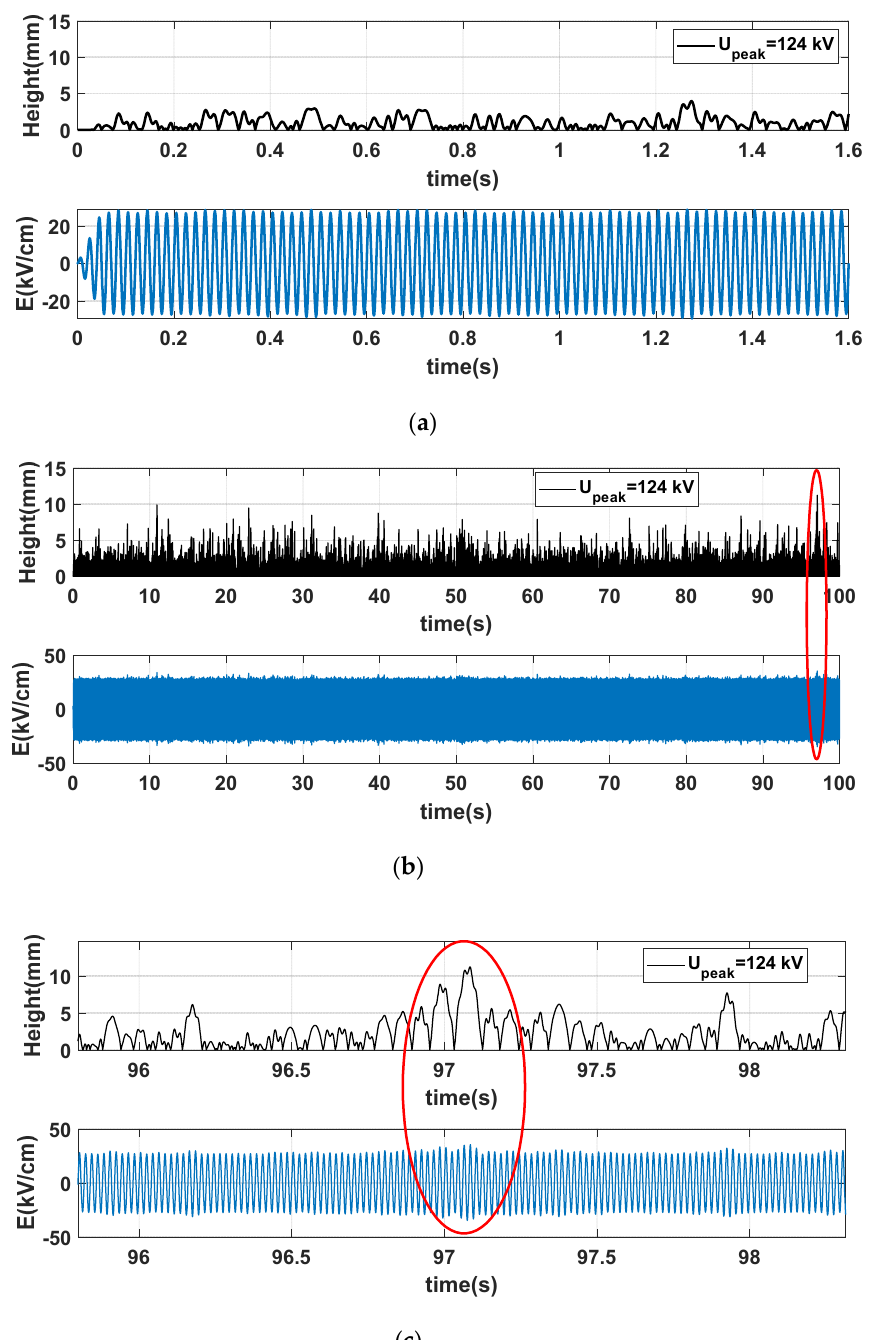
Figure 10. Simulated particle movements in CO 2 /O 2 at 0.75 MPa with a 4 mm particle length and 0.9 mm diameter in set-up 2 at applied voltage peak of 124 kV, top plots. ( a ) Simulations over 1.6 s voltage application time. ( b ) Simulations over 100 s voltage application time. Details of the event at around 97 s are shown in ( c ). In the simulations the voltage was ramped up to the maximum voltage within 50 ms. The lower plots show the electric field strength at the center of the particle location.